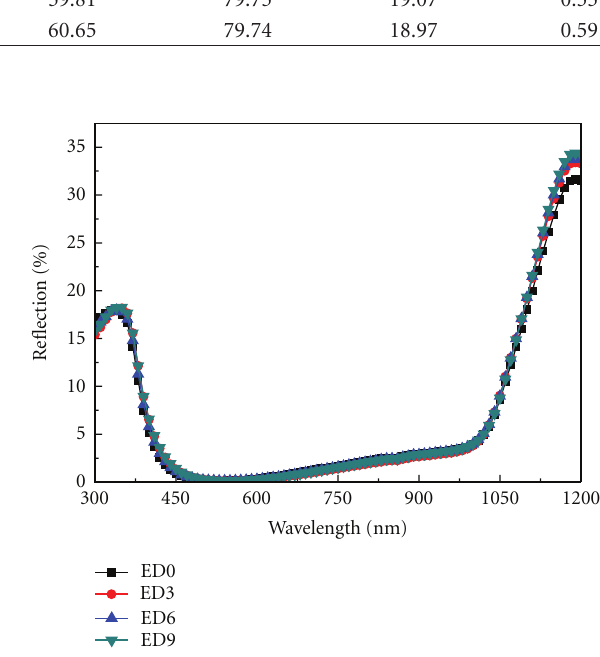
Figure 4: Comparison of reflectivity of four di ff erent etching depths after backside planar process.